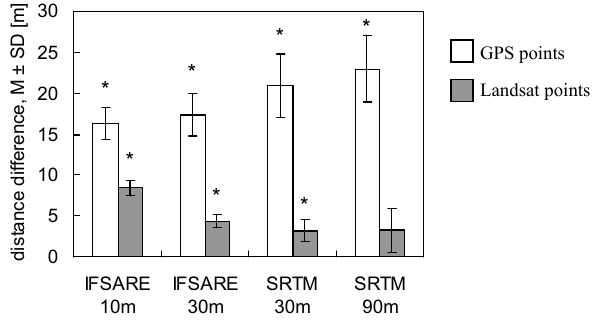
Fig. 5. Mean and standard deviation of the distance differences be- tween sink filling and least-cost path search. A positive distance dif- ference indicates that streams extracted with least-cost path search are closer to reference points than streams extracted with sink fill- ing.